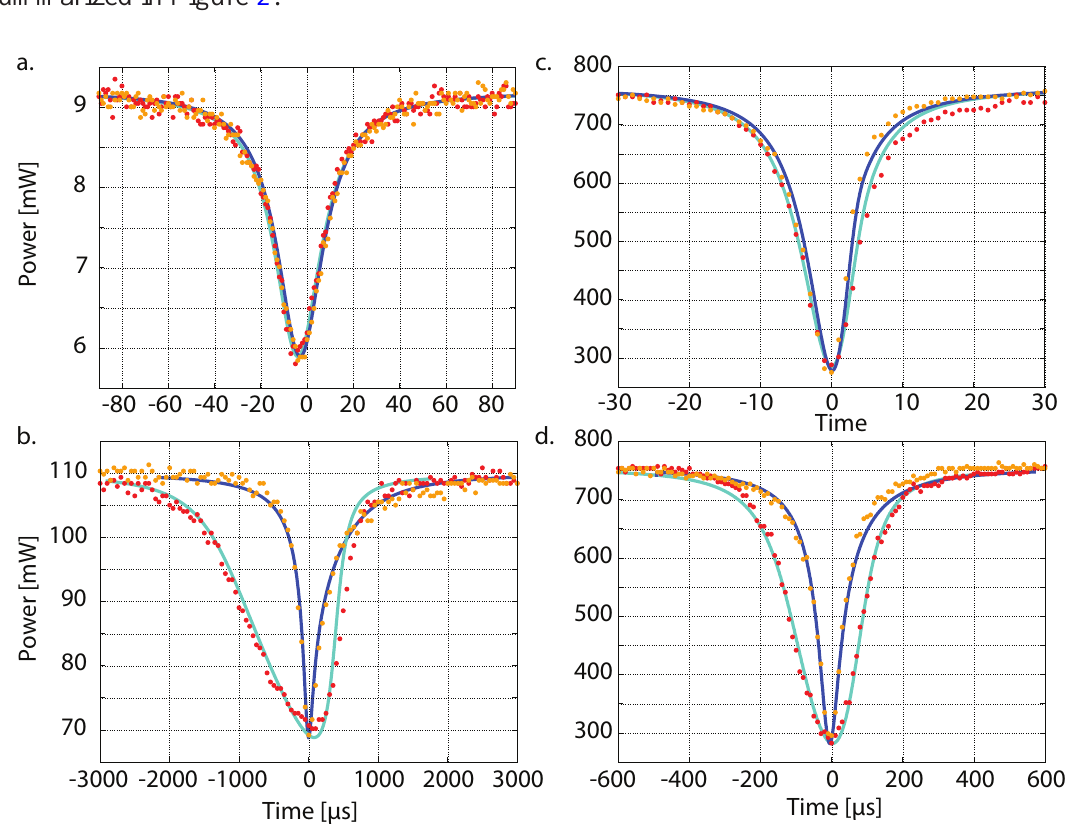
Figure 1. Measured and simulated cavity resonance peaks for an external lengthening (dark-blue line and orange dots) and external shortening (light-blue line and red dots) of the cavity (dots: measurements, lines: corresponding simulations). a and b were measured with a Fabry–Perot cavity setup at 775 nm (cavity line-width ≈ 10 MHz ) using an input power of 9 mW at a scan frequency of 550 Hz ( a ) and 110 mW at 15 Hz ( b ). c and d were measured with a bow-tie cavity setup at 1,550 nm (cavity line-width ≈ 750 kHz ) at an input power of 760 mW at scan frequencies of 149 Hz ( c ) and 11 Hz ( d ). For low power and a high scan frequency, no thermal effect occurs ( a ). For slower scan frequencies and higher powers, the narrow peaks form for an external lengthening and the broad peaks for an external shortening of the cavity ( b – d ). From those measurements we derived the absorption coefficients as summarized in Figure